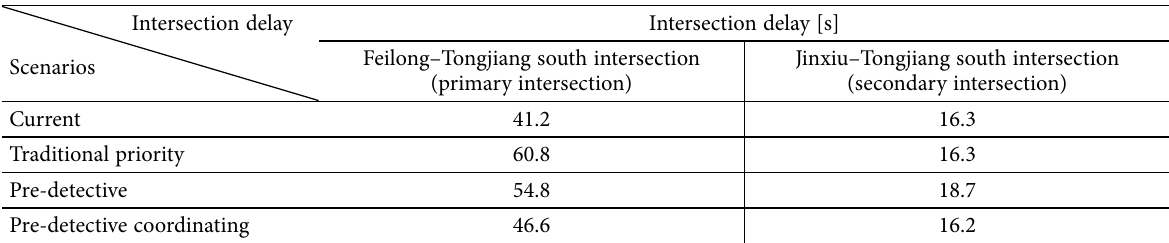
Table 4. Average intersection delay of private